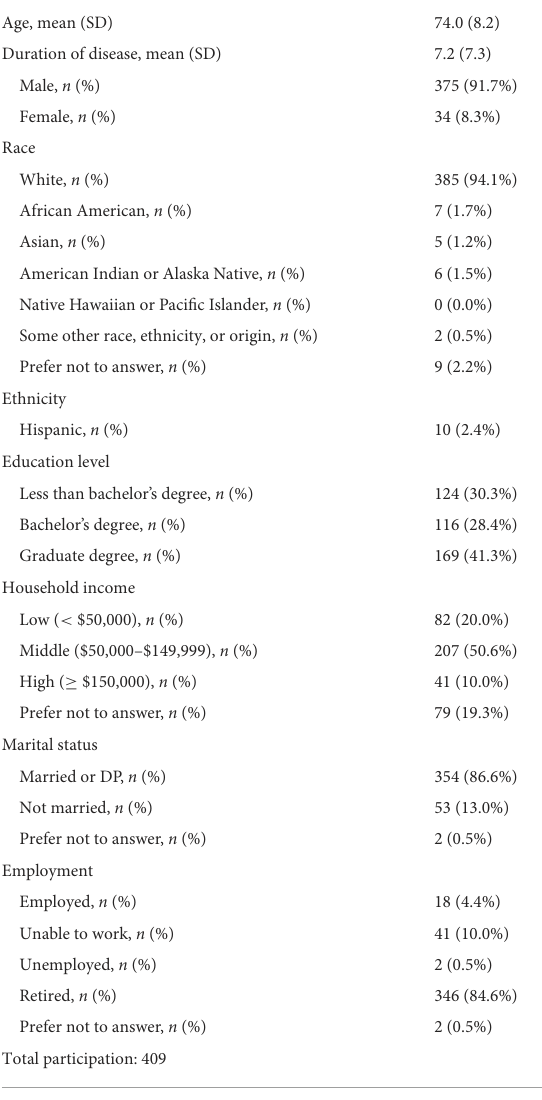
TABLE 1 Characteristics of the study population. TABLE 2 Adjusted analysis of individuals receiving services through